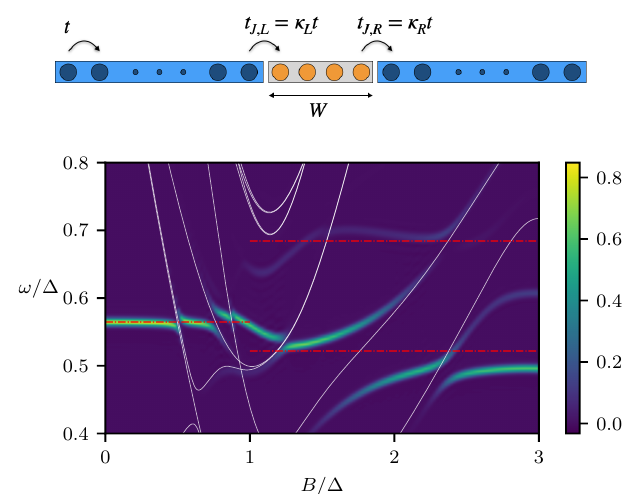
Figure 6: (a) Finite-length junction model. Sites depicted in blue correspond to the two parts of the nanowire which are proximitized. The orange sites in the middle re- gion are not subject to a superconducting pairing term, but otherwise have the same model parameters as the rest of the wire. The hopping and the spin-orbit coupling between the proximity-coupled left (right) part of the wire and the normal junction region are reduced by a factor κ compared to their values in the bulk. (b) The L ( R ) spectral function for a finite-length junction model as a function of the Zeeman en- = 0. Junction parameters are E = 0.1, E 0 = 0.5, N = 0, and wire ergy B for N g c g J = κ = 0.3. The length tight-binding parameters are t = 1.5, v = 2, µ = 0, κ L R = 30, and the of each part of the wire that is coupled to a superconductor is N x length of the junction is W = 6. Red dashed lines, plotted on top of the spectral function for B < B ( B > B ), are the spectral lines expected deep in the trivial (topo- c c logical) phase (see main text for more details). White solid lines are the energies of 2-quasiparticle excitations obtained from the BdG Hamiltonian for a phase difference of φ = 0 between the superconducting